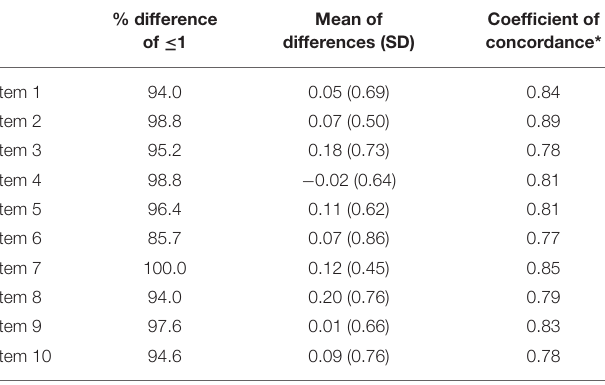
TABLE 2 | Percentage differences and coefficients of concordance between two raters on PCCP-AM items.